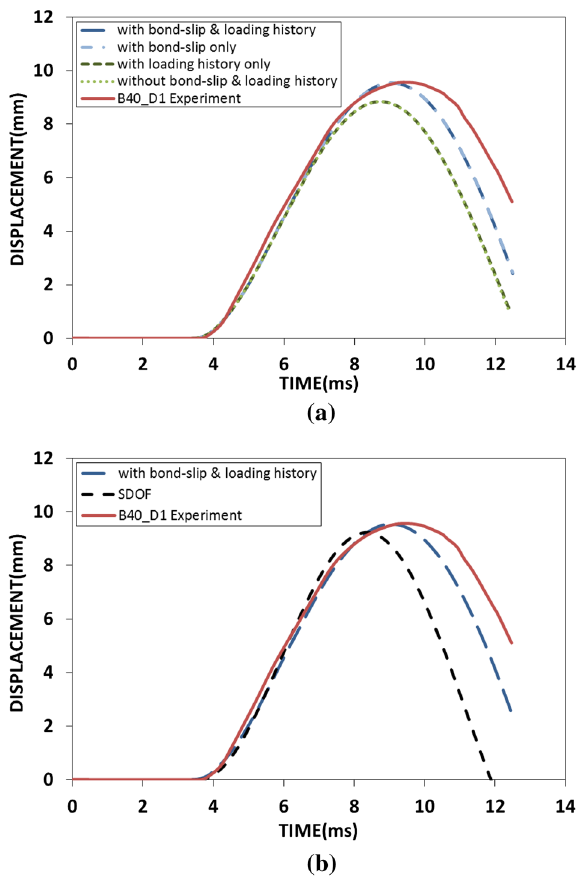
Fig. 7 Mid-span deflection with time for B40_D1. a Compar- ison with experiment and b comparison with SDOF model.